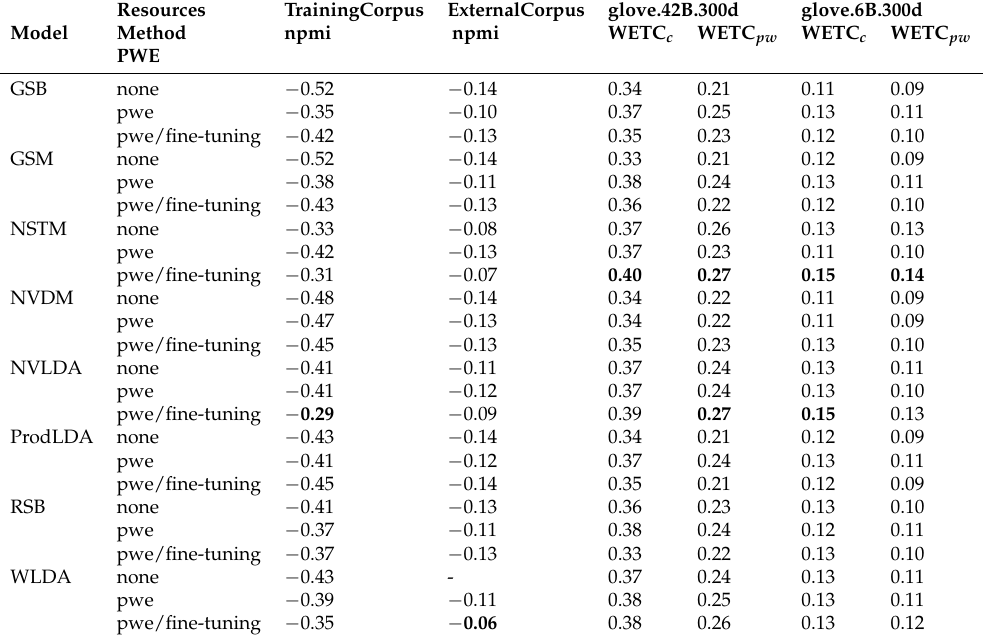
Table 6. Topic Coherence on DBLP.